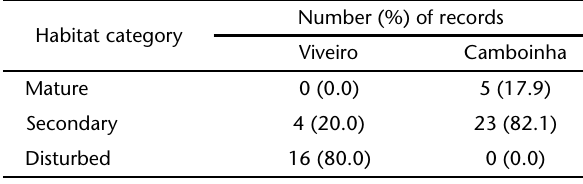
Table III. Availability of the three habitat categories in the Viveiro and Camboinha fragments at the Fazenda Trapsa, Sergipe. Habitat